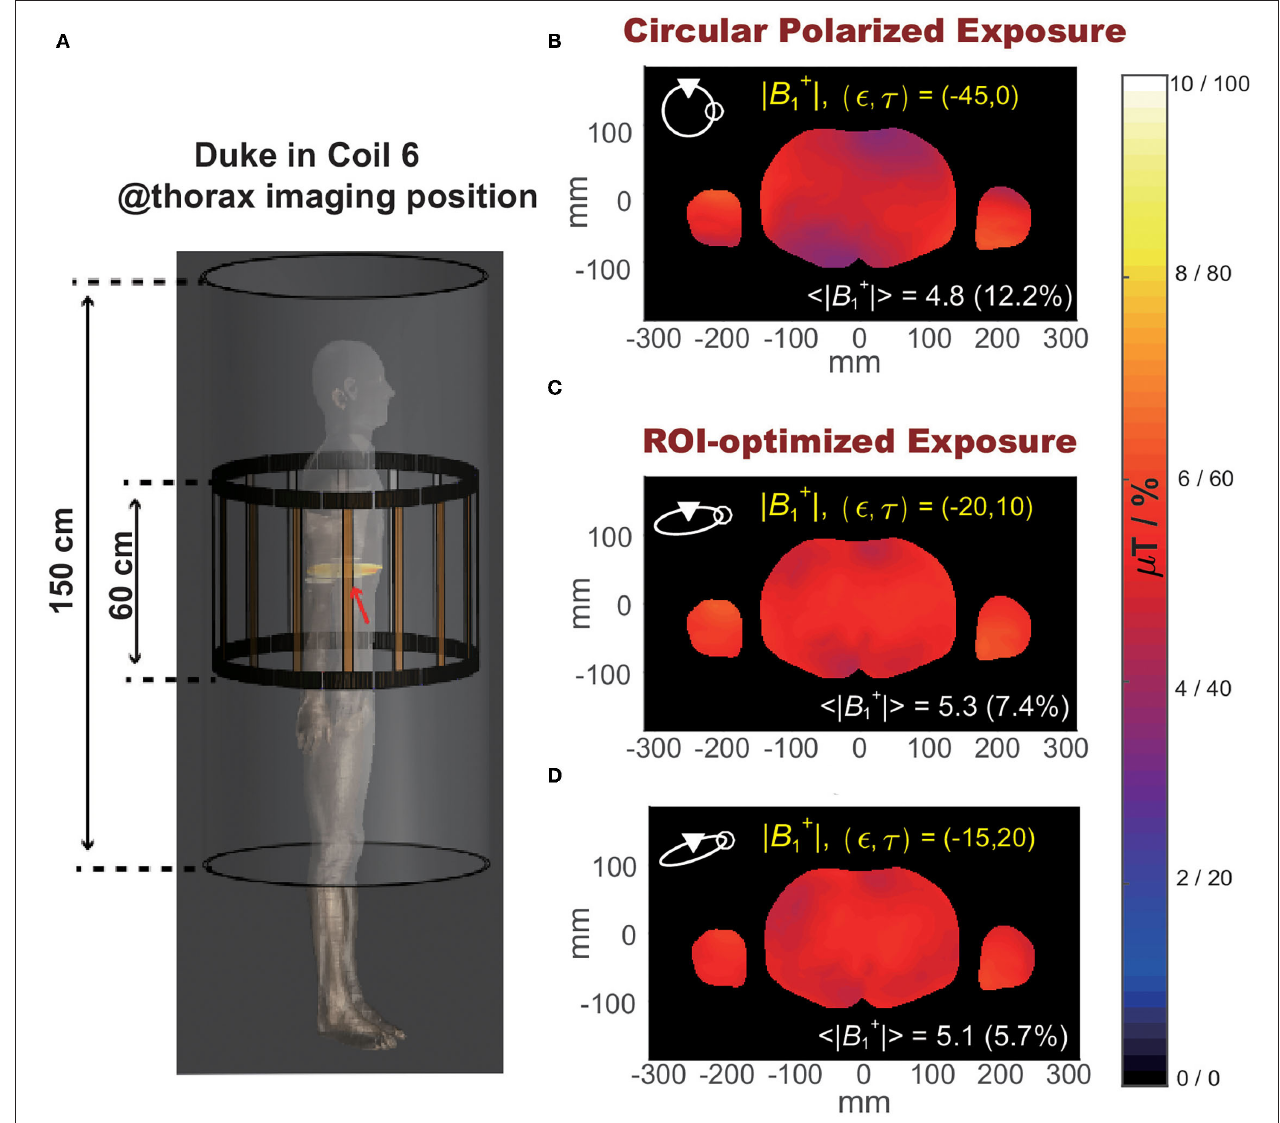
FIGURE 6 | (A) Illustration of the selected clinical scenario: Duke in RF coil 6 at thorax imaging position. (B) Spatial distribution of B + 1 magnitude at an iso-center slice of Duke under circular polarized B 1 field. (C) Spatial distribution of B + 1 magnitude at the iso-center slice of Duke under optimized exposure condition resulting in maximum B + 1 magnitude. (D) Spatial distribution of B + 1 magnitude over iso-center slice of Duke under optimized exposure condition resulting in minimum B + 1, cov